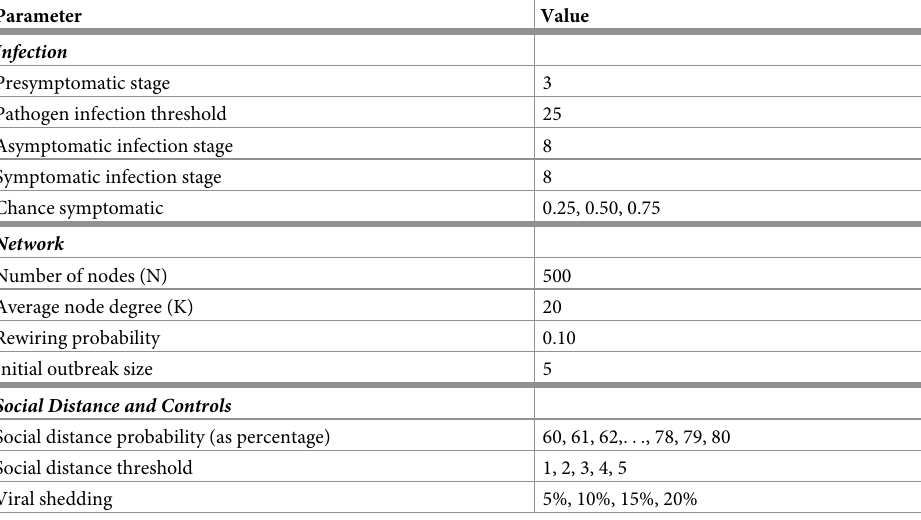
Table 2. Secondary simulation parameters.